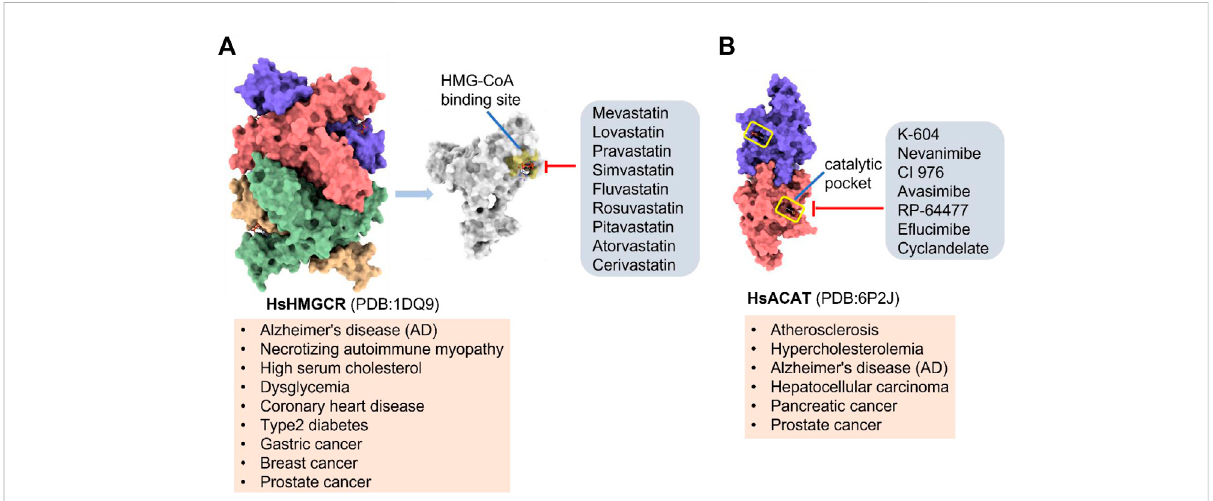
Potential pharmacological targets and related inhibitors targeting cholesterol synthesis and storage, with related diseases are listed under the each structure model. (A) Homotetramer structure of human 3-hydroxy-3-methylglutaryl-coenzyme A reductase (HMGCR) and single sununit structure highlighted with the HMG-CoA binding pocket. Statin inhibitors of HMGCR competitively occupy the HMG-CoA binding site and block HMG-CoA from contacting the catalytic center. Several statin inhibitors that have been intensively studied mainly include Mevastatin, Lovastatin,Pravastatin,Simvastatin, Fluvastatin,Rosuvastatin,Pitavastatin, Atorvastatin,Cerivastatin. (B) DimerstructureofhumanAcyl-coenzymeA: cholesterolacyltransferase1(ACAT)withcatalyticpockethighlighted.NotbleinhibitorsforACATincludeK-604,Nevanimibe,CI976,Avasimibe,RP- 64477, E fl ucimibe and